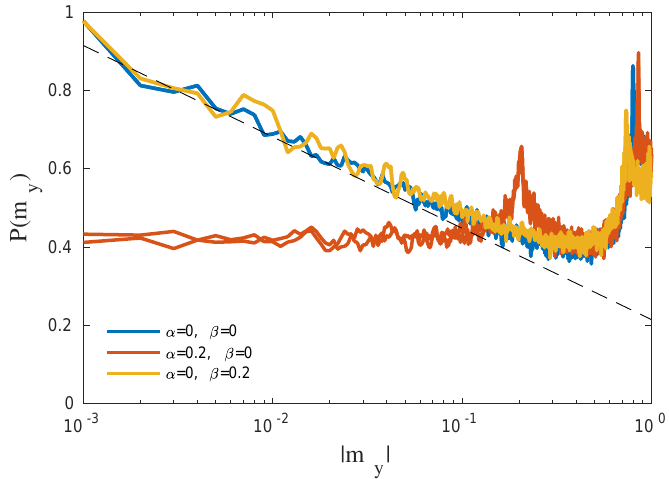
= S / S ≈ φ , Eq. 6, for the general- y y is relevant and destroys z is irrelevant and does not affect x